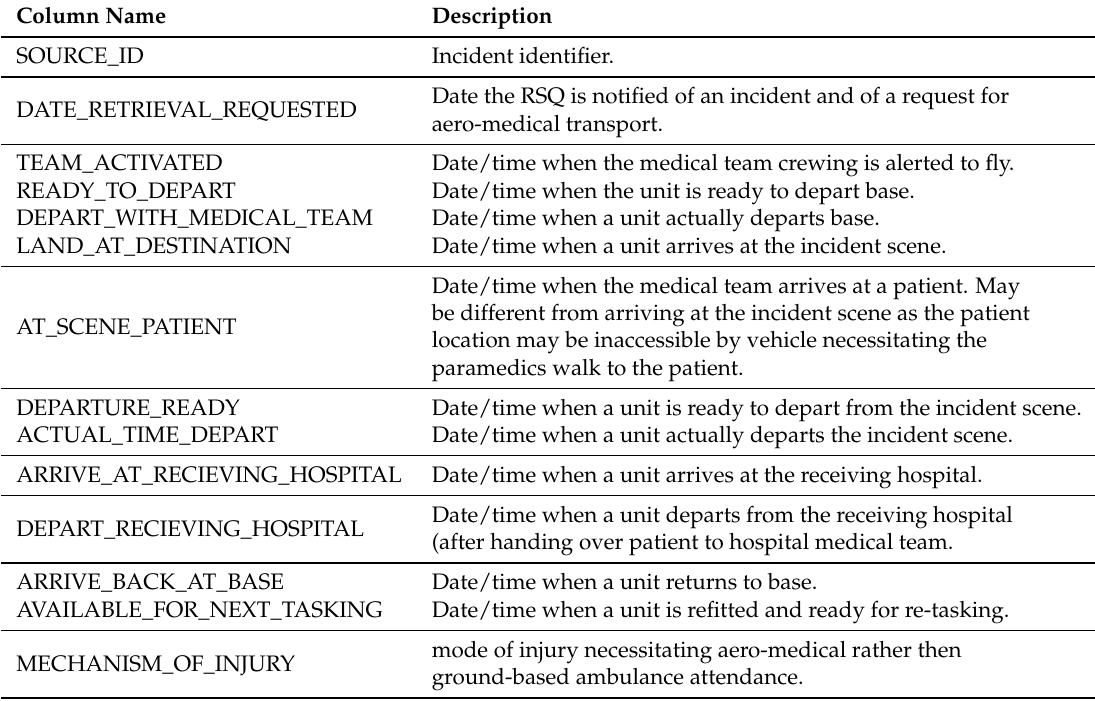
Table 3. RSQ—Data attributes and descriptions.